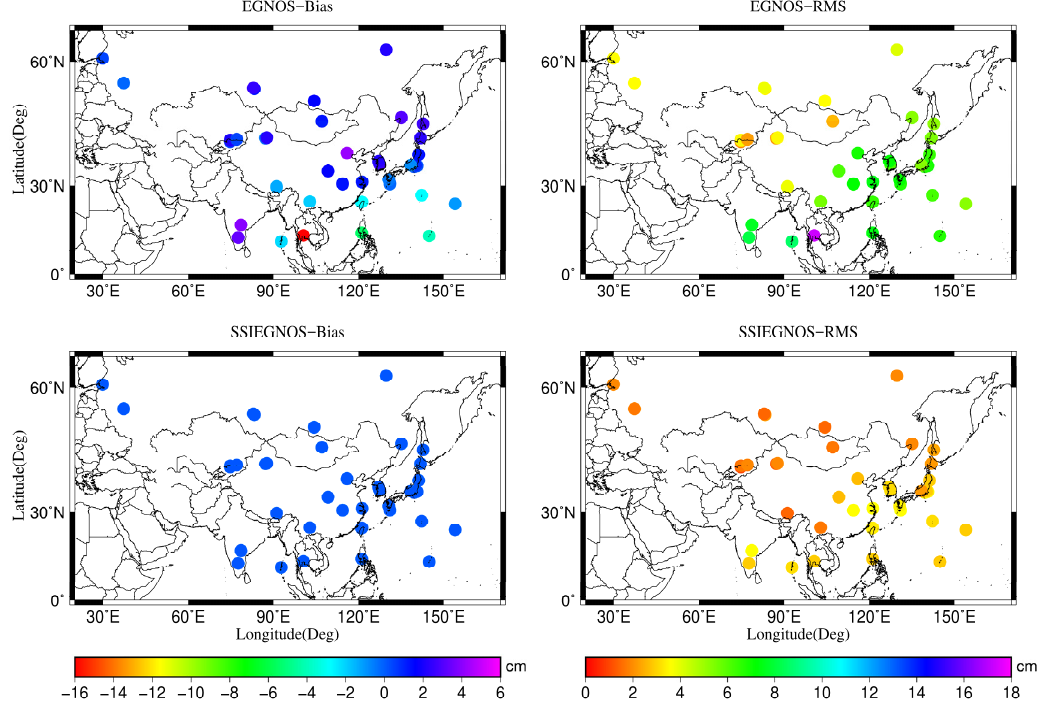
Figure 5. Distribution of annual bias and RMS error of the EGNOS and SSIEGNOS models from 2008–2010 over Asia. The color denotes the magnitude of the annual bias and RMS error.